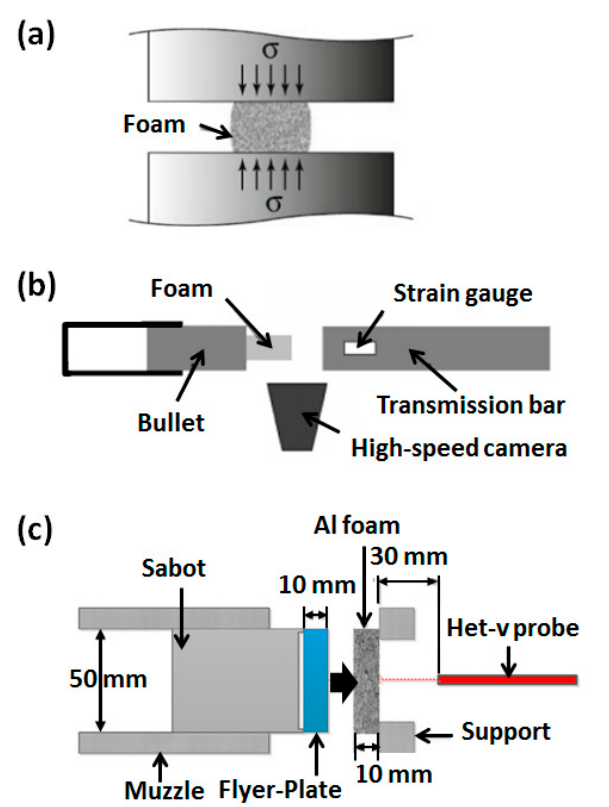
Figure 3. Schematic diagram of ( a ) quasi-static loading, (~10 0 s − 1 ) [32], ( b ) dynamic impact test (10 1 –10 5 s − 1 ) [33], and ( c ) flyer-plate impact test (~10 6 s − 1 ) [34].